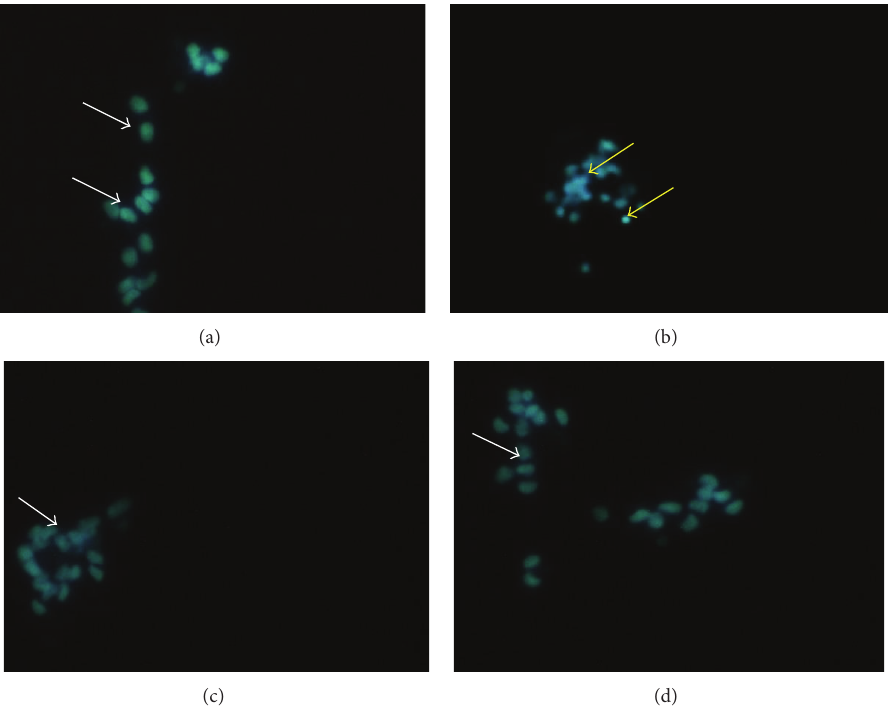
Figure 3: Hoechst staining in differentiated SH-SY5Y cells after treatment. (a) Control, (b) glutamate (20mM), (c) glutamate (20 mM) +